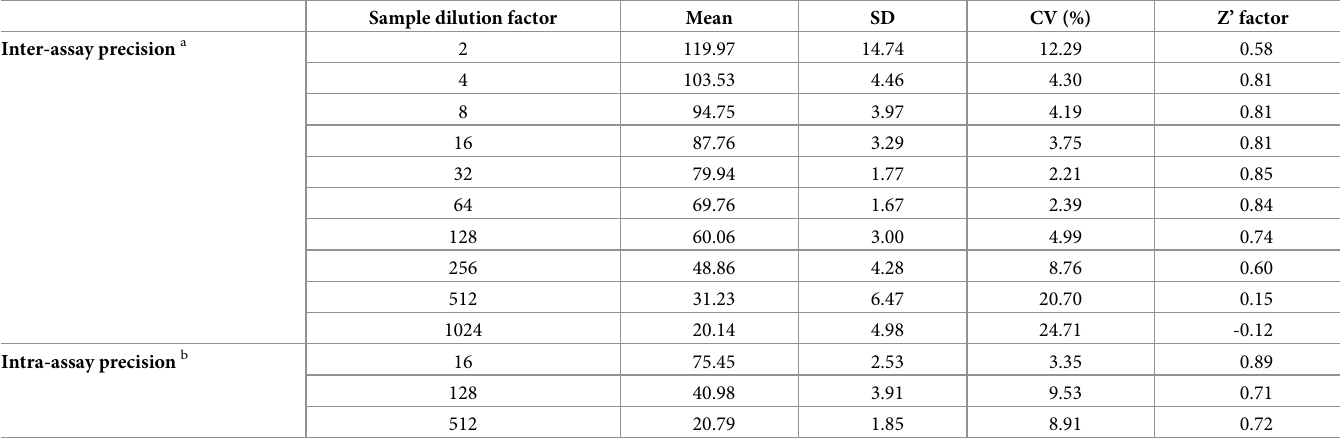
Mean of normalized positive area is given in %, standard deviation (SD), coefficient of variation (CV), and Z’-factor. a n = 3, b n = 10.